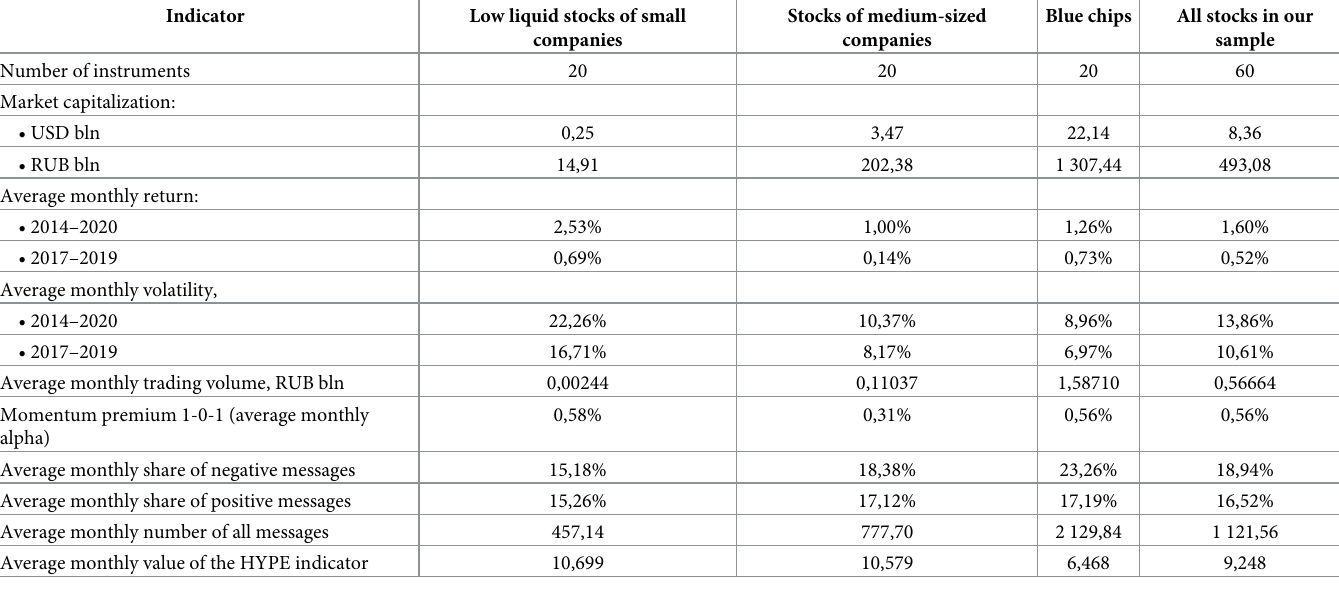
Table 2. The descriptive statistics on our